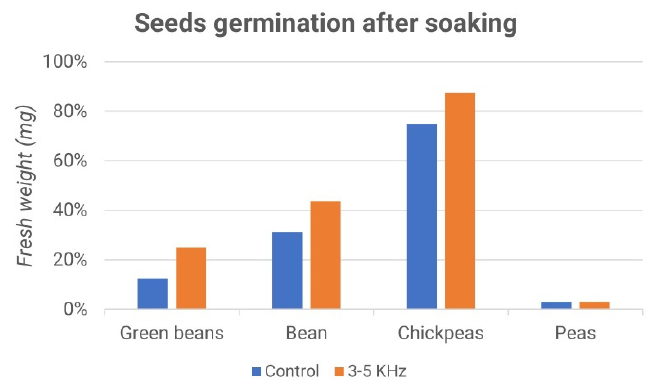
Figure 18. Seed germination after soaking: fresh weight vs. samples (green beans, bean, chickpeas and peas); control (blue) and 3–5 kHz stimulation (orange).